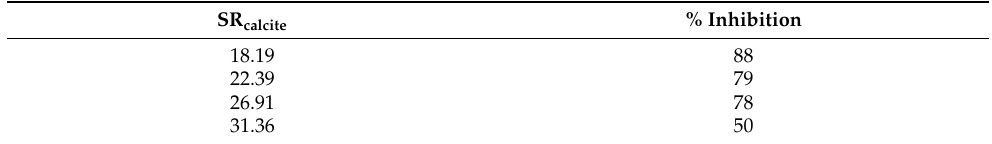
Table 5. % Inhibition of the precipitation of calcium carbonate and the corresponding values of the supersaturation ratio with respect to calcite in the presence of 6 μ M of nickel, under illumination and in the presence of 20 mL of active A. obliquus culture; 25 °C, pH 8.50, 0.15 M of NaCl.